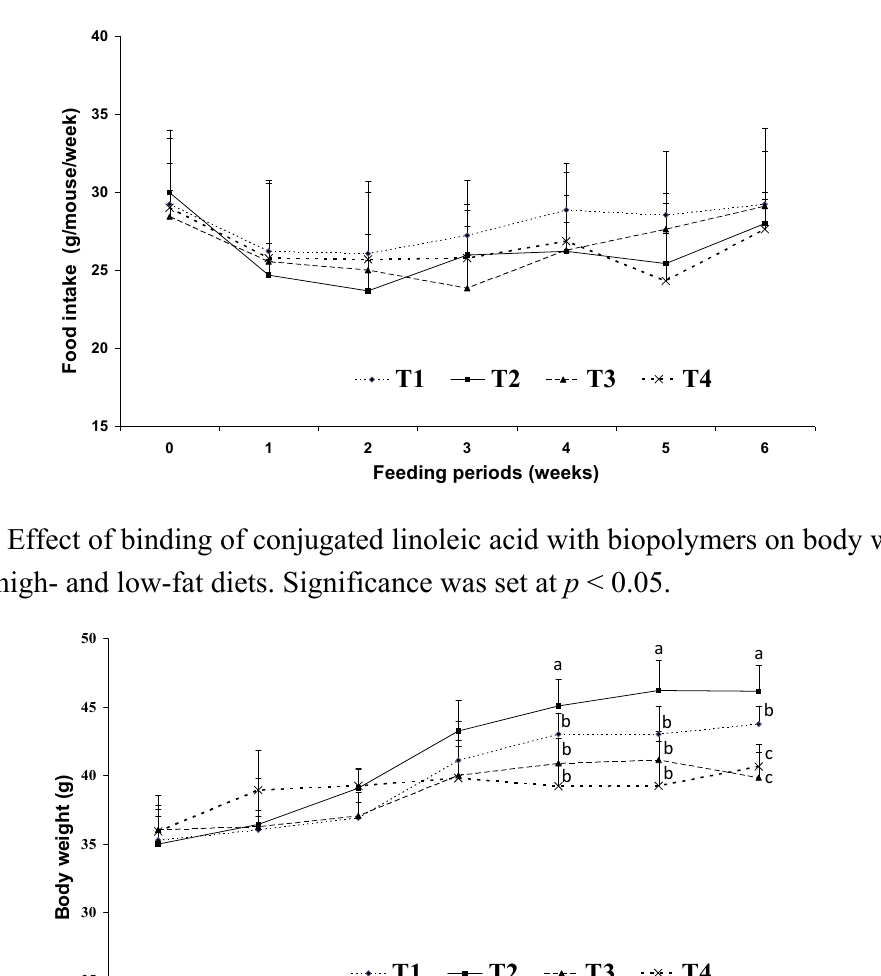
Figure 1. Effect of binding of conjugated linoleic acid with biopolymers on food intakes in mice fed high- and low-fat diets. Significance was set at p < 0.05.